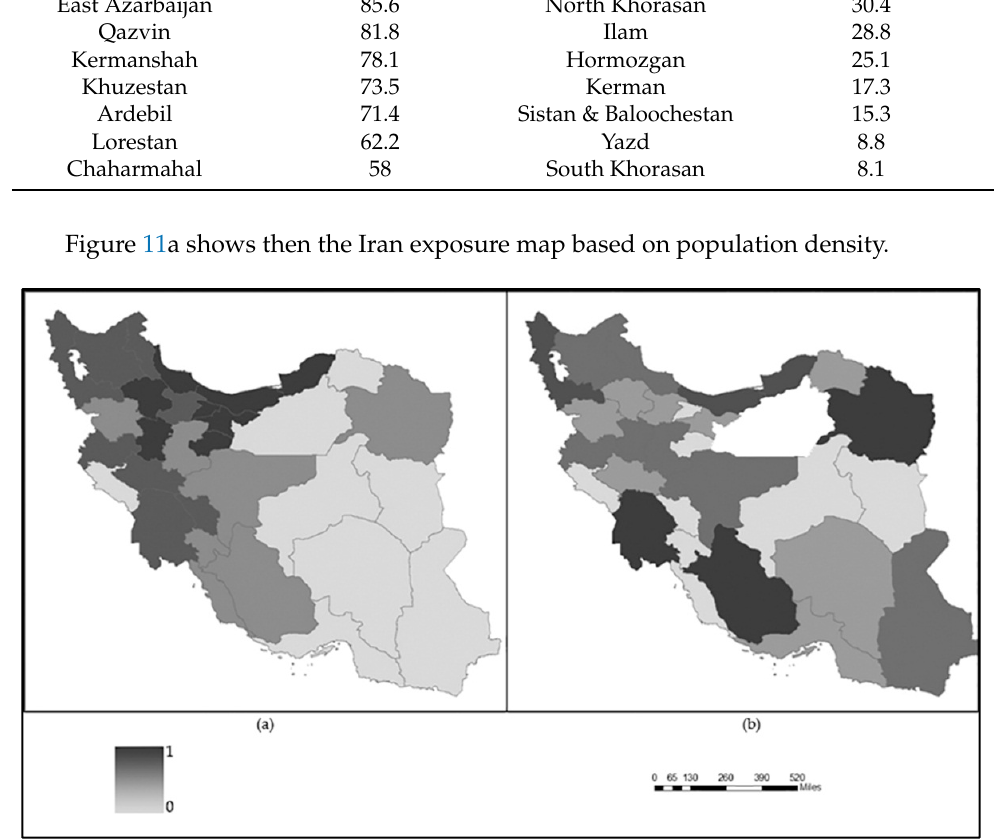
Figure 11. ( a ) Exposure map based on population density ( Iran Census Center , 2016). ( b ) Exposure map based on irrigation percentage ( Ministry of Agriculture , 2016).